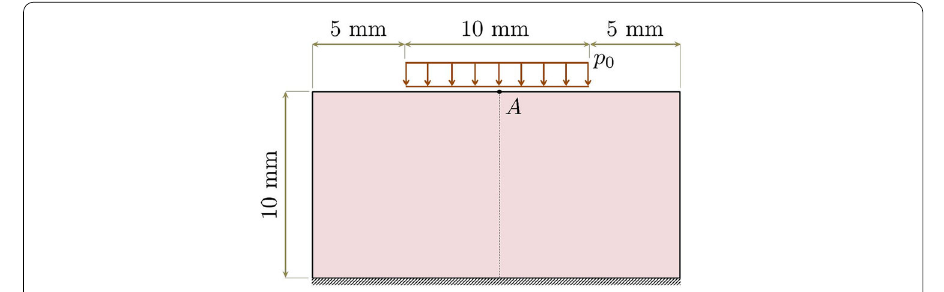
Fig. 8 Thin beam, geometry, boundary conditions, loading and discretization